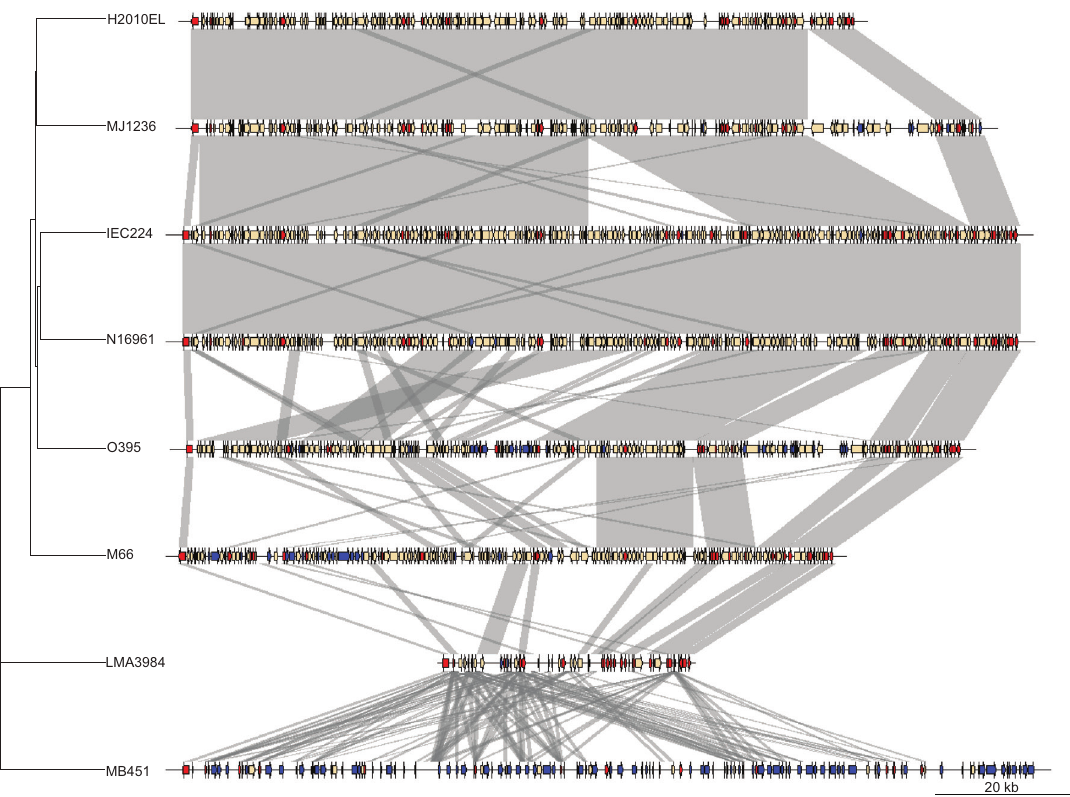
Figure 3. Superintegron (SI) structure and comparison of seven strains of V. cholerae and a strain of V. mimicus . The core, dispensable and unique genes are indicated by red, cream and blue arrows, respectively. Vertical blocks between sequences indicate regions with more than 1 kb of shared similarity shaded according to BLASTn. A phylogenetic tree based on gene content of the SI is shown on the left.